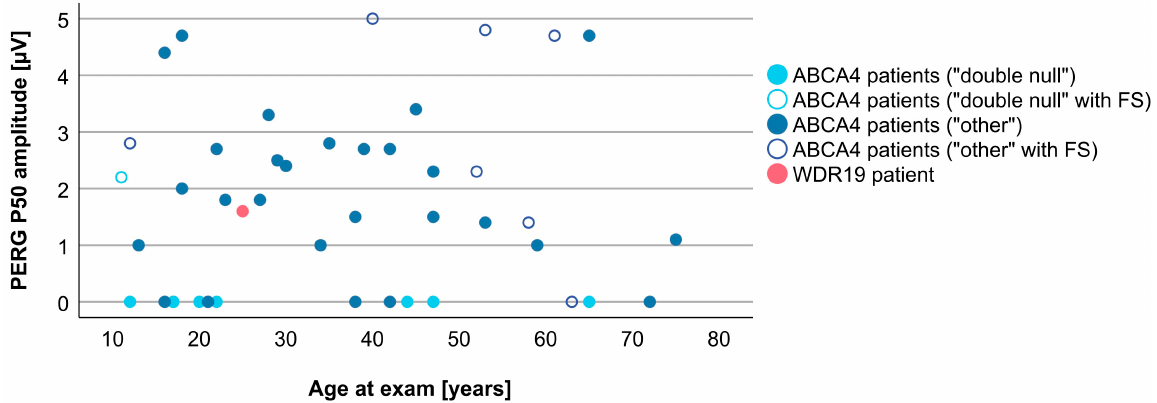
Figure 10. Comparison of PERG P50 amplitudes (representing macular function) between WDR19 patient (red), double null ABCA4 patients (light blue) and ABCA4 patients with other genotypes (dark blue). Foveal sparing patients are marked with empty circles.